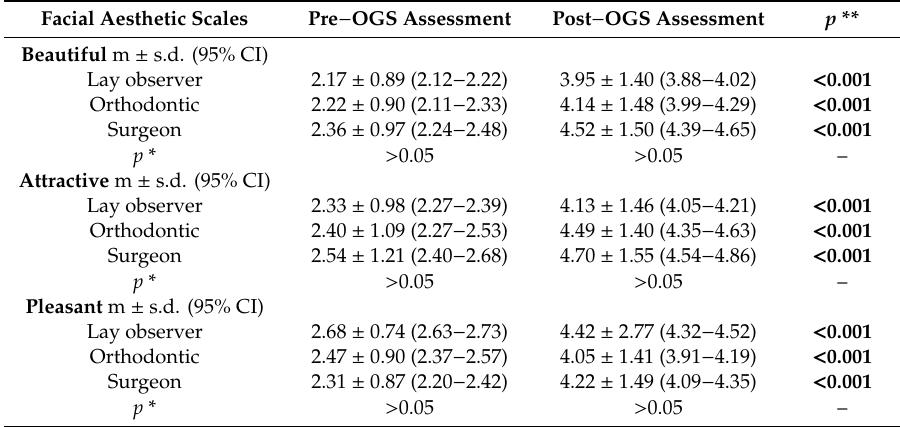
Bold values indicate statistical significance after Bonferroni correction. OGS, orthognathic surgery; m, mean; s.d., standard deviation; CI, confidence interval; p , p − value; –, not applicable; *, comparisons among the groups of raters; **, pre − OGS versus post − OGS scores